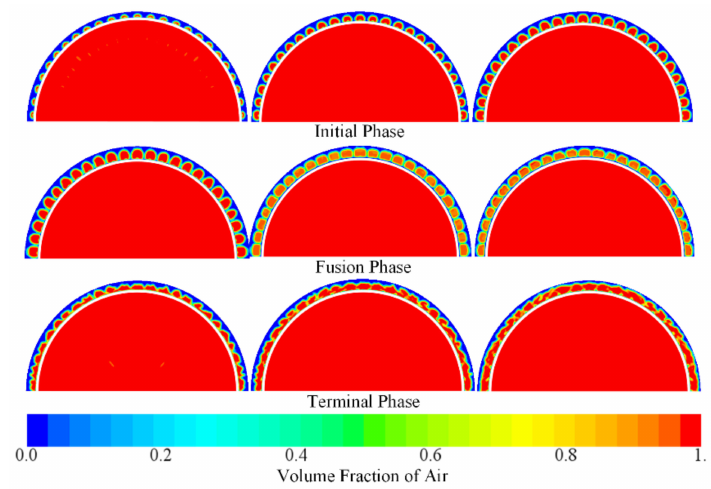
Figure 12. Distribution of phase volume fraction.